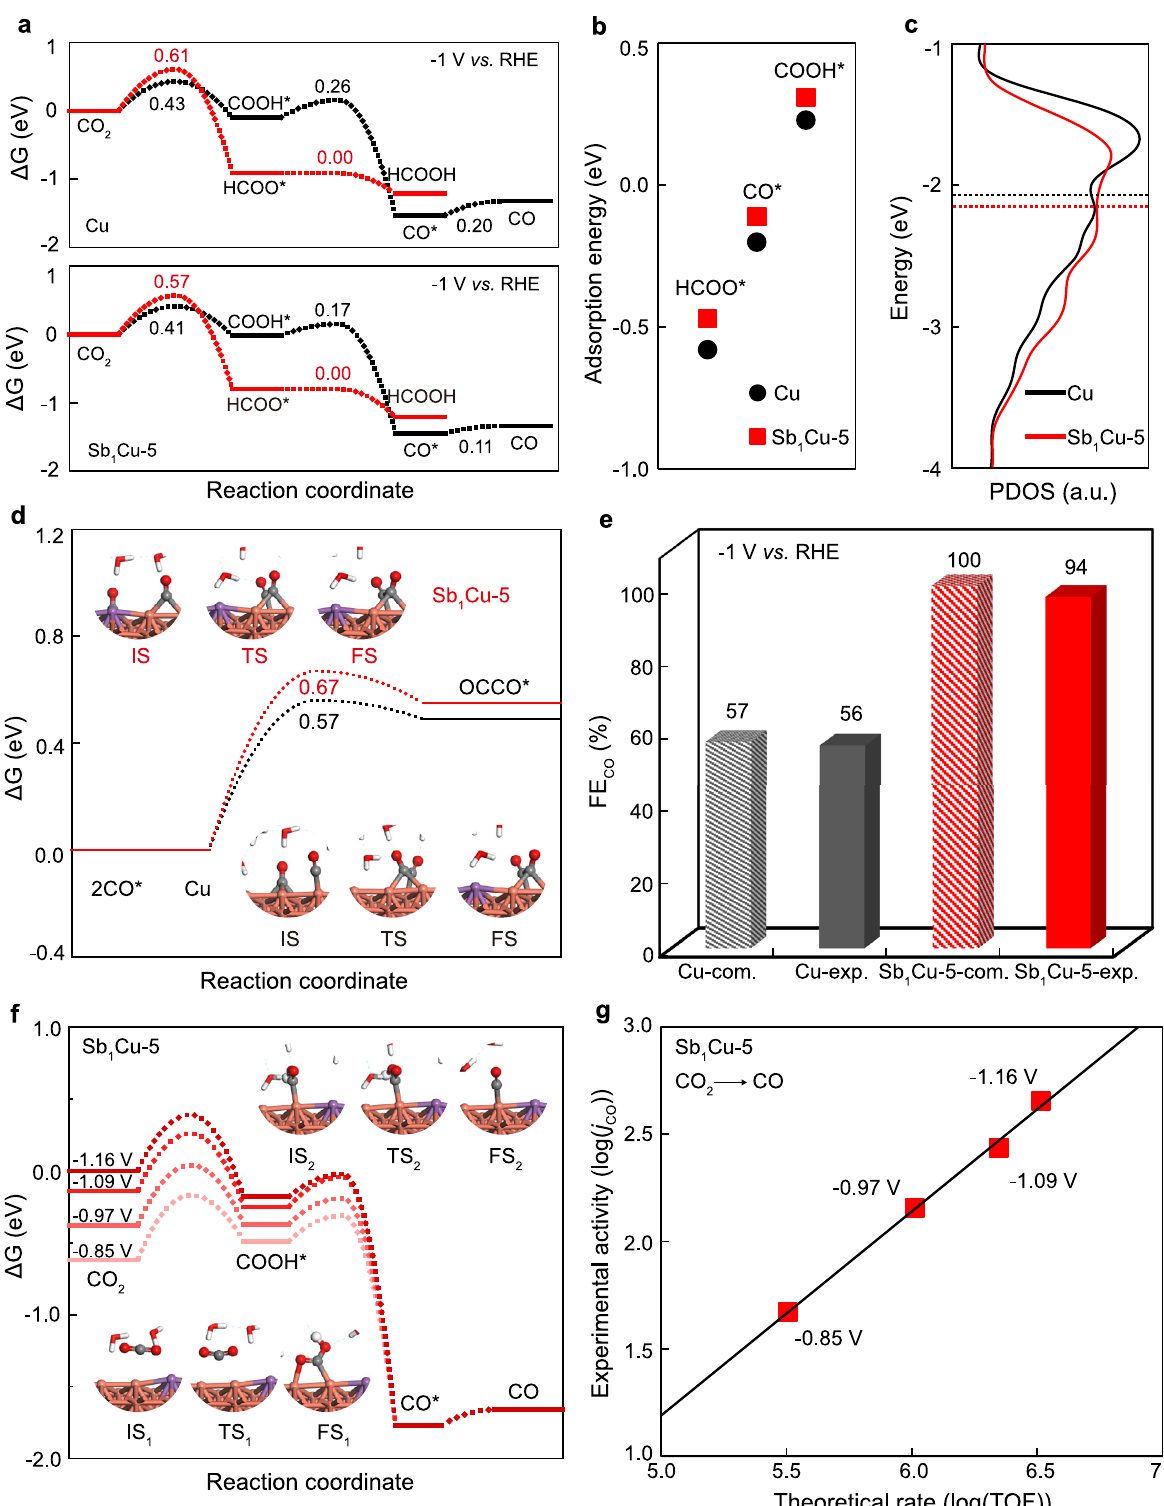
Fig. 4 | Theoretical calculations. a CO 2 RR to CO and HCOOH on Cu (211) and Sb 1 Cu-5(211). b TheadsorptionenergiesofHCOO*,CO*andCOOH*onCu(211)and Sb 1 Cu-5 (211). c The projected d-band states of Cu atoms on Cu (211) and Sb 1 Cu-5 (211). d Barriersfor CO*-CO*coupling on Cu (211) and Sb 1 Cu-5 (211).The initial (IS), transition(TS),and fi nal(FS)structuresareshownasinsets,whereCu,Sb,C,O,and H are represented in orange, purple, gray, red, and white, respectively.